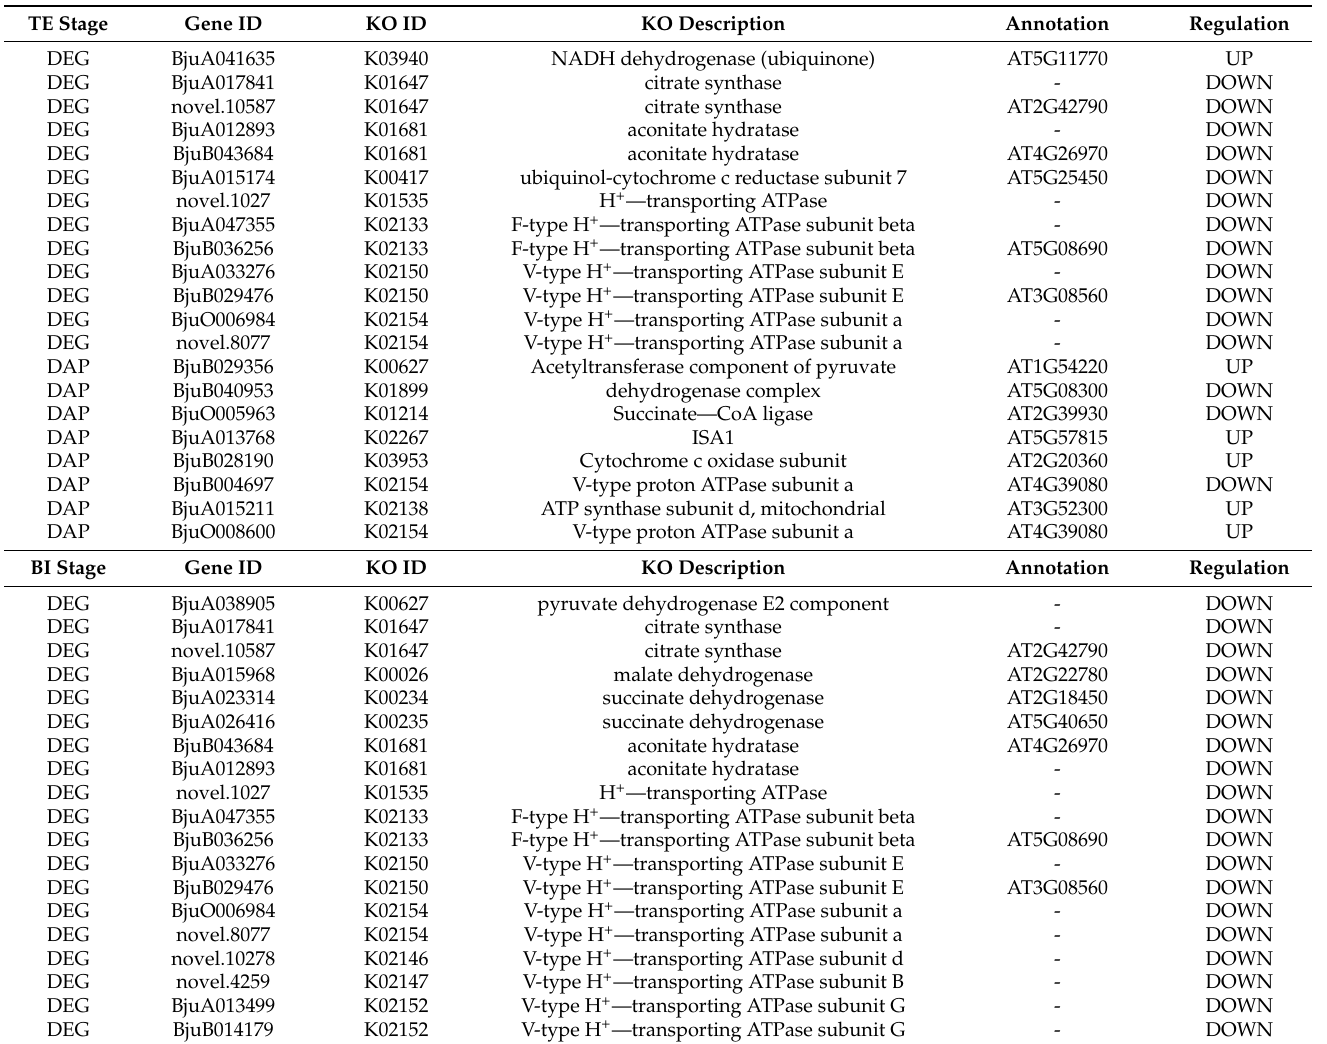
Table 2. List of DEGs and DAPs associated with energy metabolism in 09-05A/B lines of B. juncea